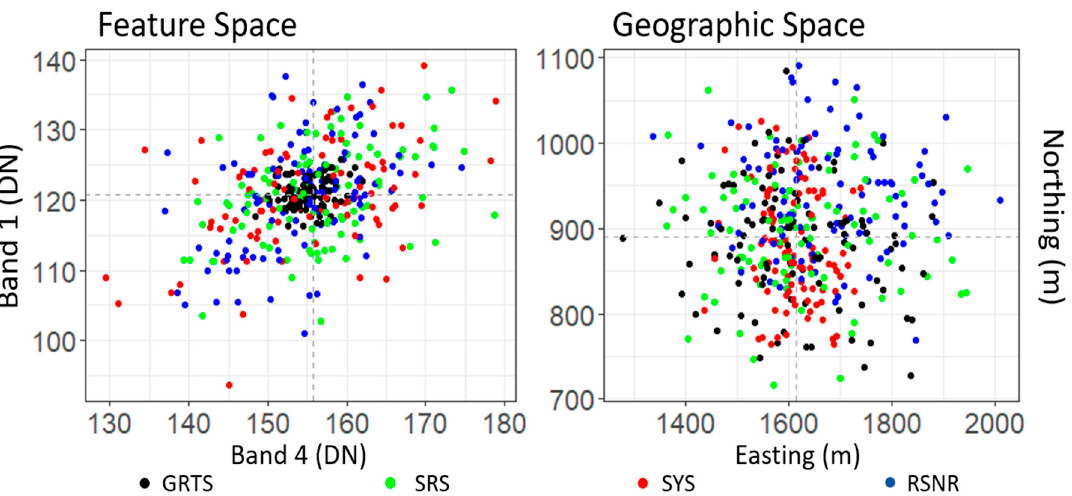
Figure 3. Distribution of sample mean digital number (DN) values of bands 1 and 4 ( left panel; Feature Space) and sample mean northing and easting values ( right panel; Geographic Space) for 100 samples obtained from generalized random tessellation stratified (GRTS), simple random Scheme 50. was used for each of the 100 samples.